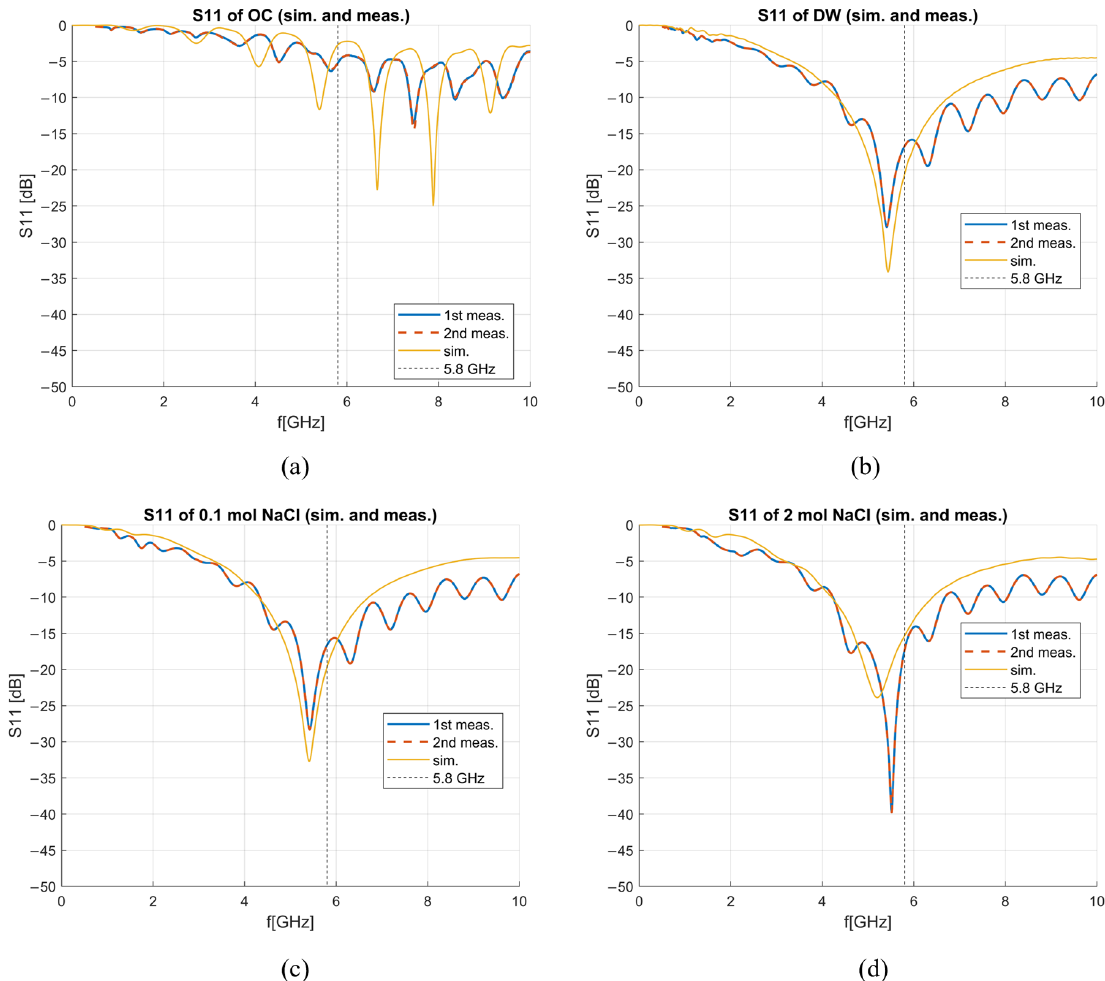
Figure 4. Simulated and measured reflection coefficients in dB for ( a ) open circuit, ( b ) deionized water, ( c ) 0.1 mol NaCl solution, ( d ) 2 mol NaCl solution.